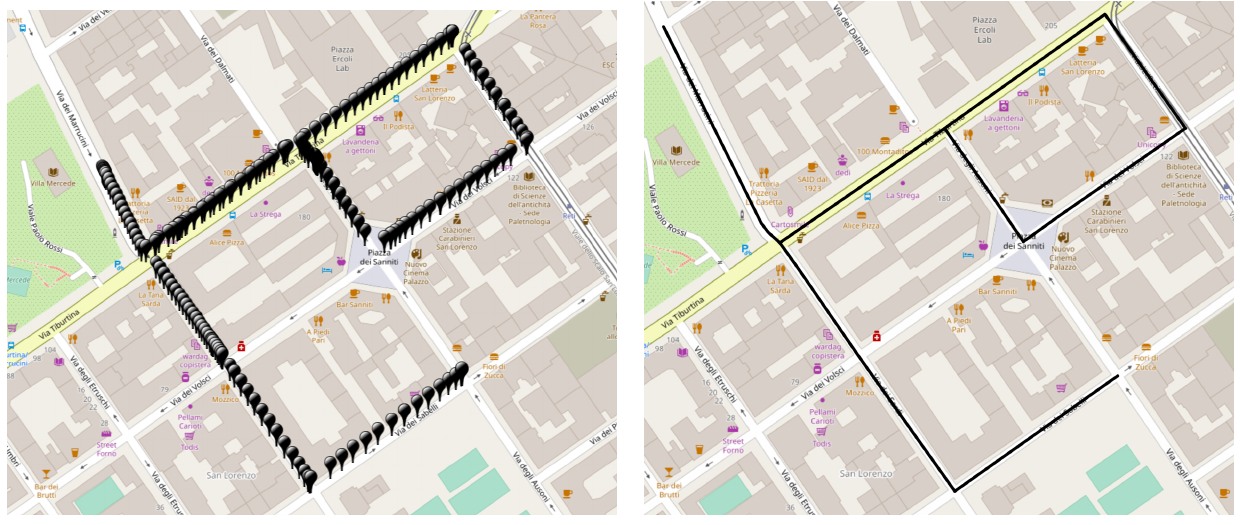
Figure 4. Map-Matching